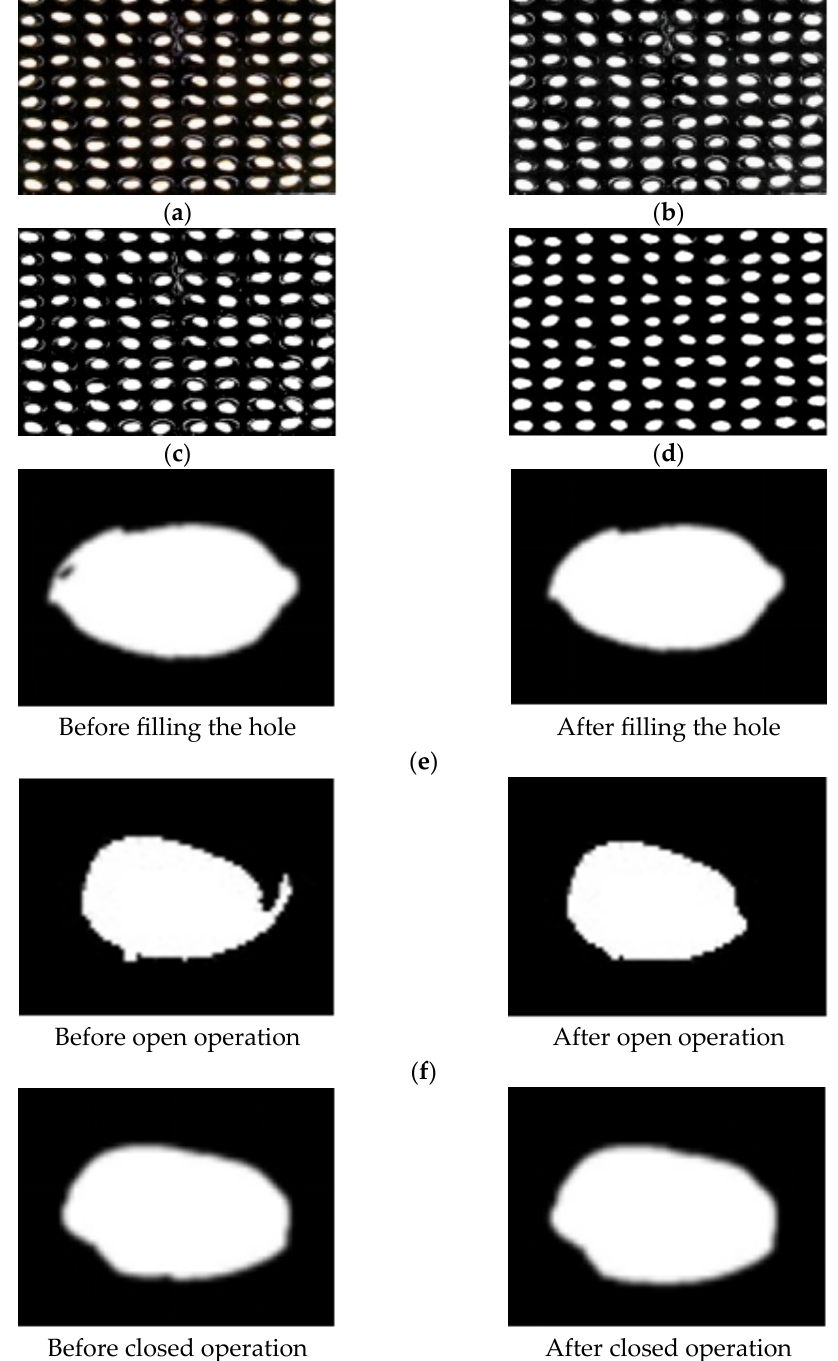
Figure 5. Wheat seed image preprocessing results. Select the maximum method to grayscale the image, and then adopt the Otsu algorithm to binary the image. Choose the area filtering algorithm to filter the image noise. The basic binary morphological operations used in this paper to apply hole filling and two complex morphological operators—open operation and closed operation, which effectively eliminate the holes in the wheat seeds, and smooth the boundary of the wheat seeds. ( a ) Original image. ( b ) Greyscale image. ( c ) Binarized image. ( d ) Area filtered image. ( e ) Comparison chart of hole fi lling. ( f ) Comparison image of open operation. ( g ) Comparison image of closed oper- ation.